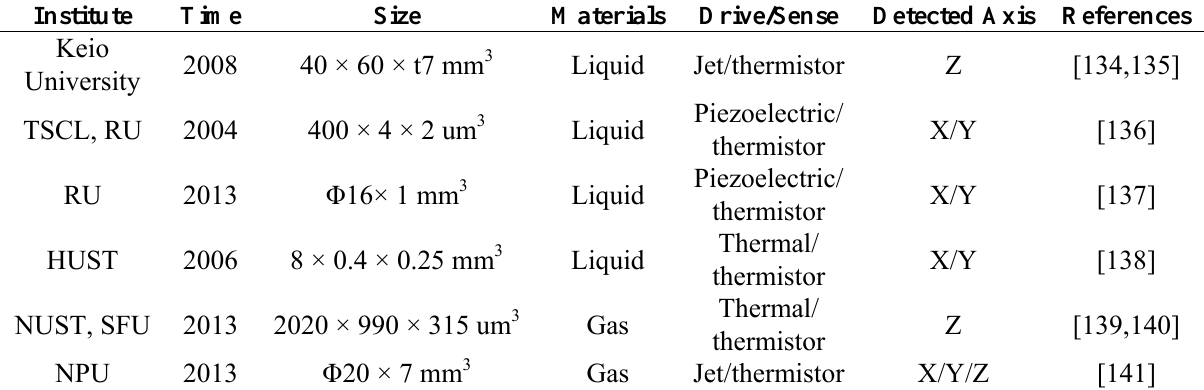
Table 11. The summary of micro fluid